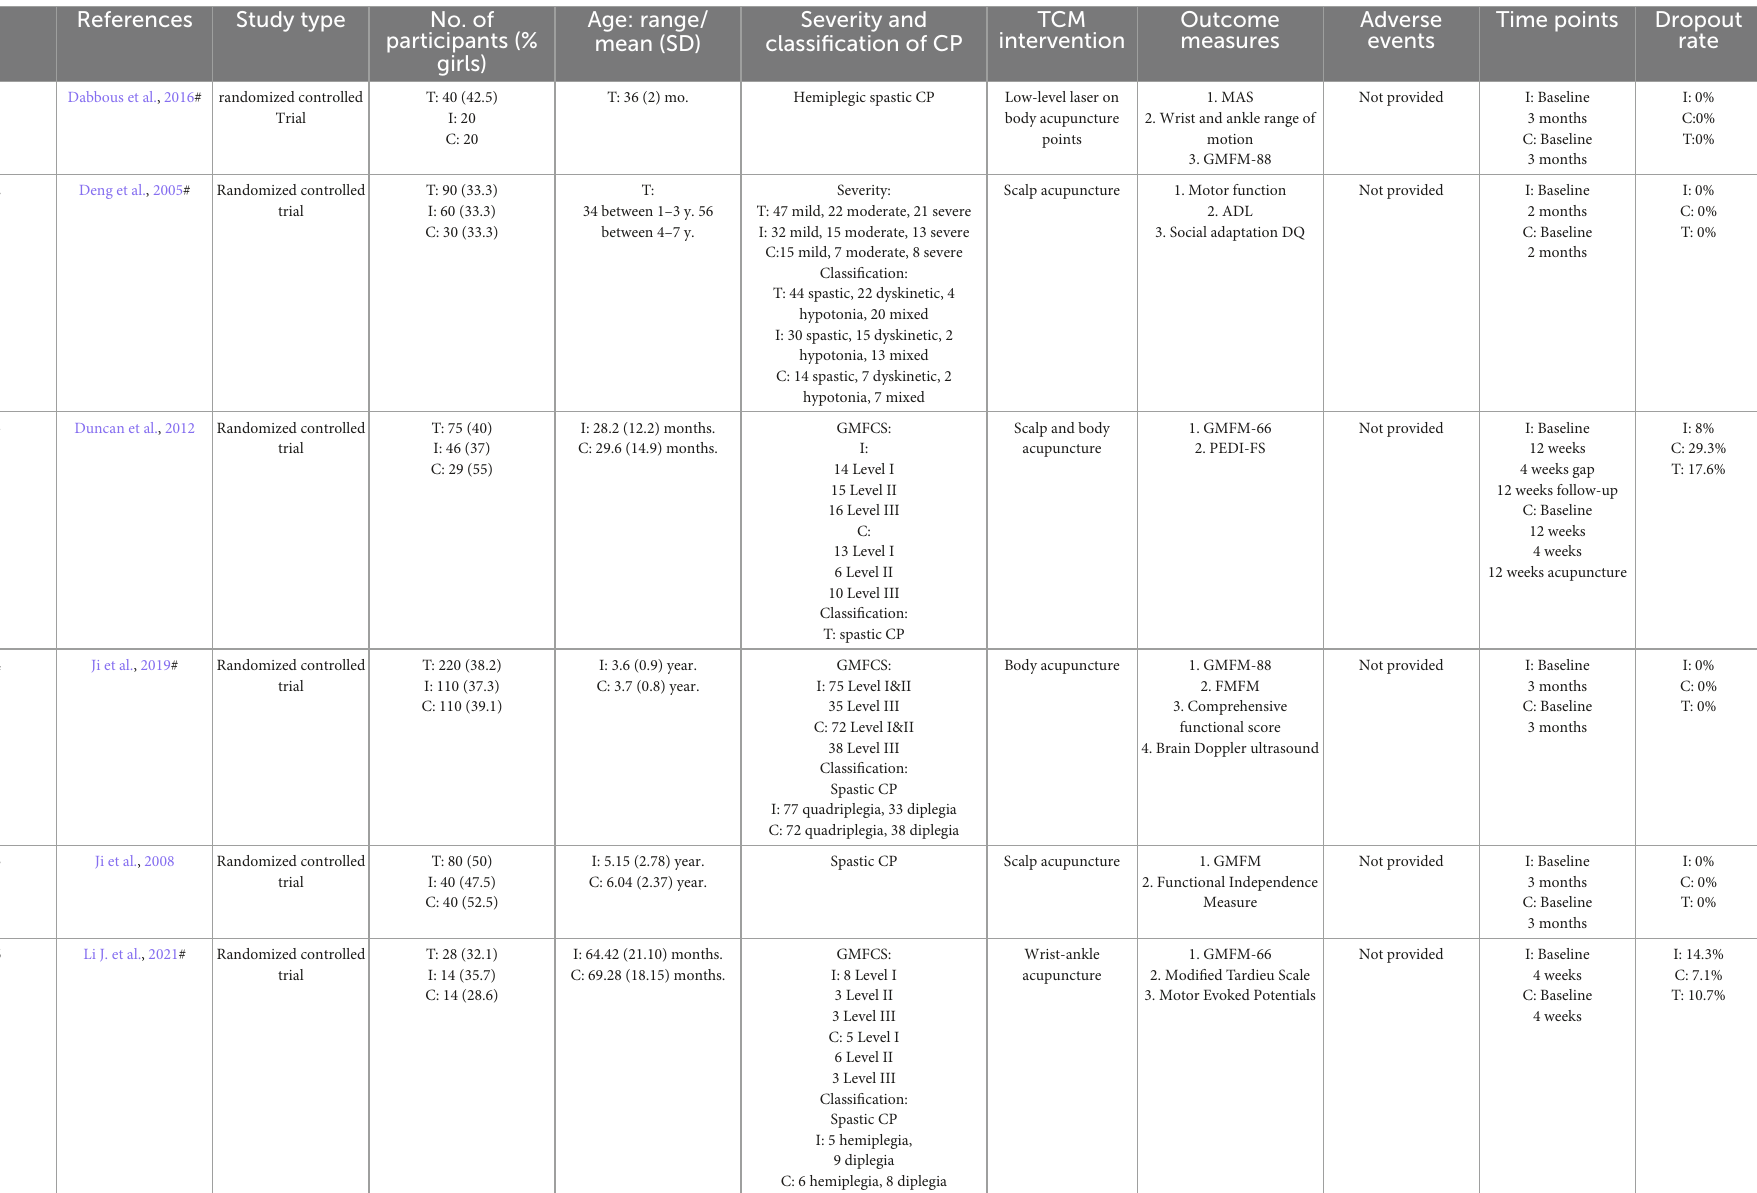
TABLE 1 Baseline demographic and clinical characteristics of study